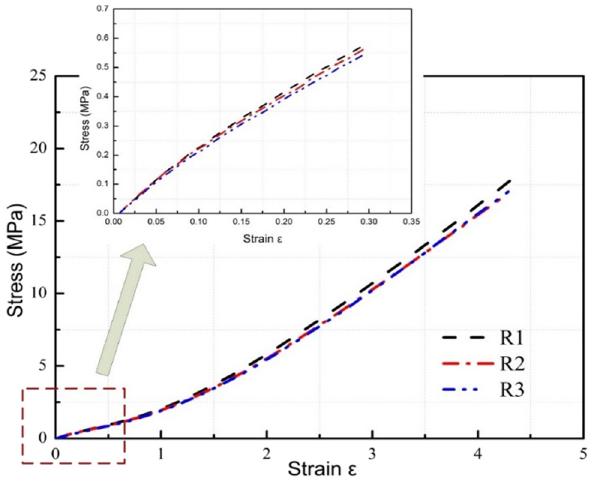
Figure 5: Stress – strain curve of